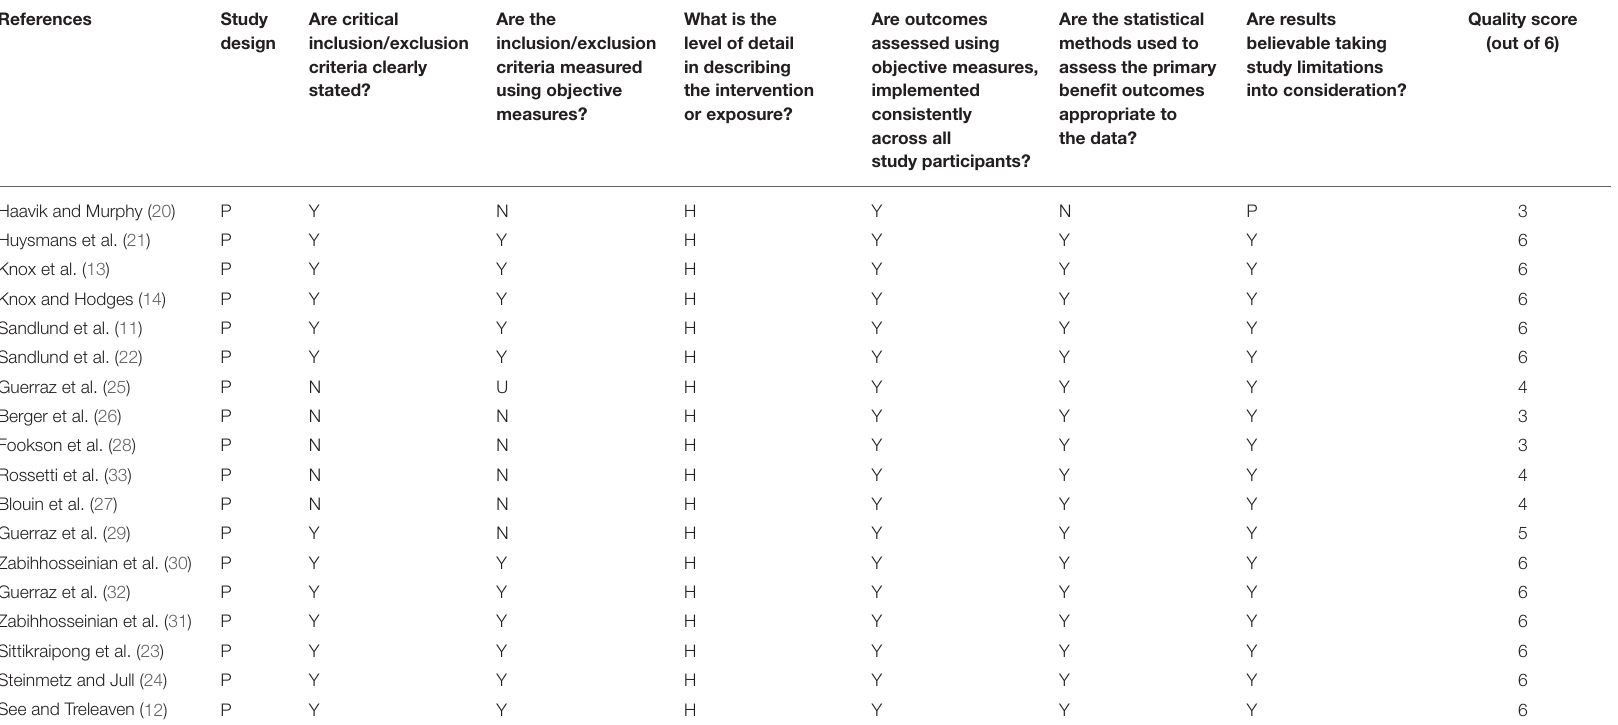
TABLE 1 | Risk of bias [adapted from Viswanathan and Berkman